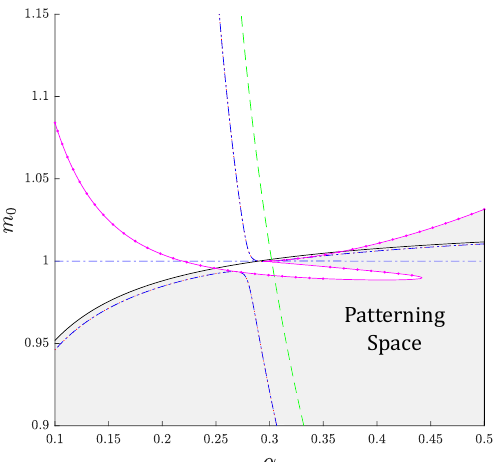
Figure 3. Patterning space for the coupled poro-mechano-chemical model. Selected interval in the ( m 0 , α ) parameter space. (black plain) boundary built from (15a) for θ 1 ; (green-dashed) bound- ary from (15a) for θ 2 ; (red-dot-dot) boundary from (15b); (blue-dot-dashed) boundary from (15c); (magenta-dot-plain) boundary built from